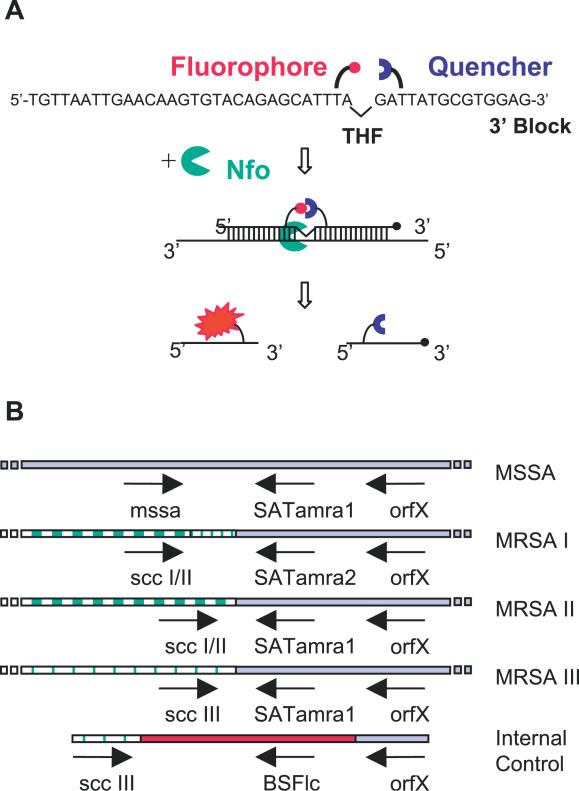
Schematic of the Probe-Based RPA Detection Method(A) Signal generation by separation of a fluorophore and a quencher depends on cutting of the probe by double-strand specific Nfo.(B) Arrangement of primers and probes relative to the targets used in
Figures 4 and
5. See
Protocol S1 for sequences of MRSA isoforms. A PCR fragment that fused an unrelated sequence to the target sites sccIII and orfX served as internal control.